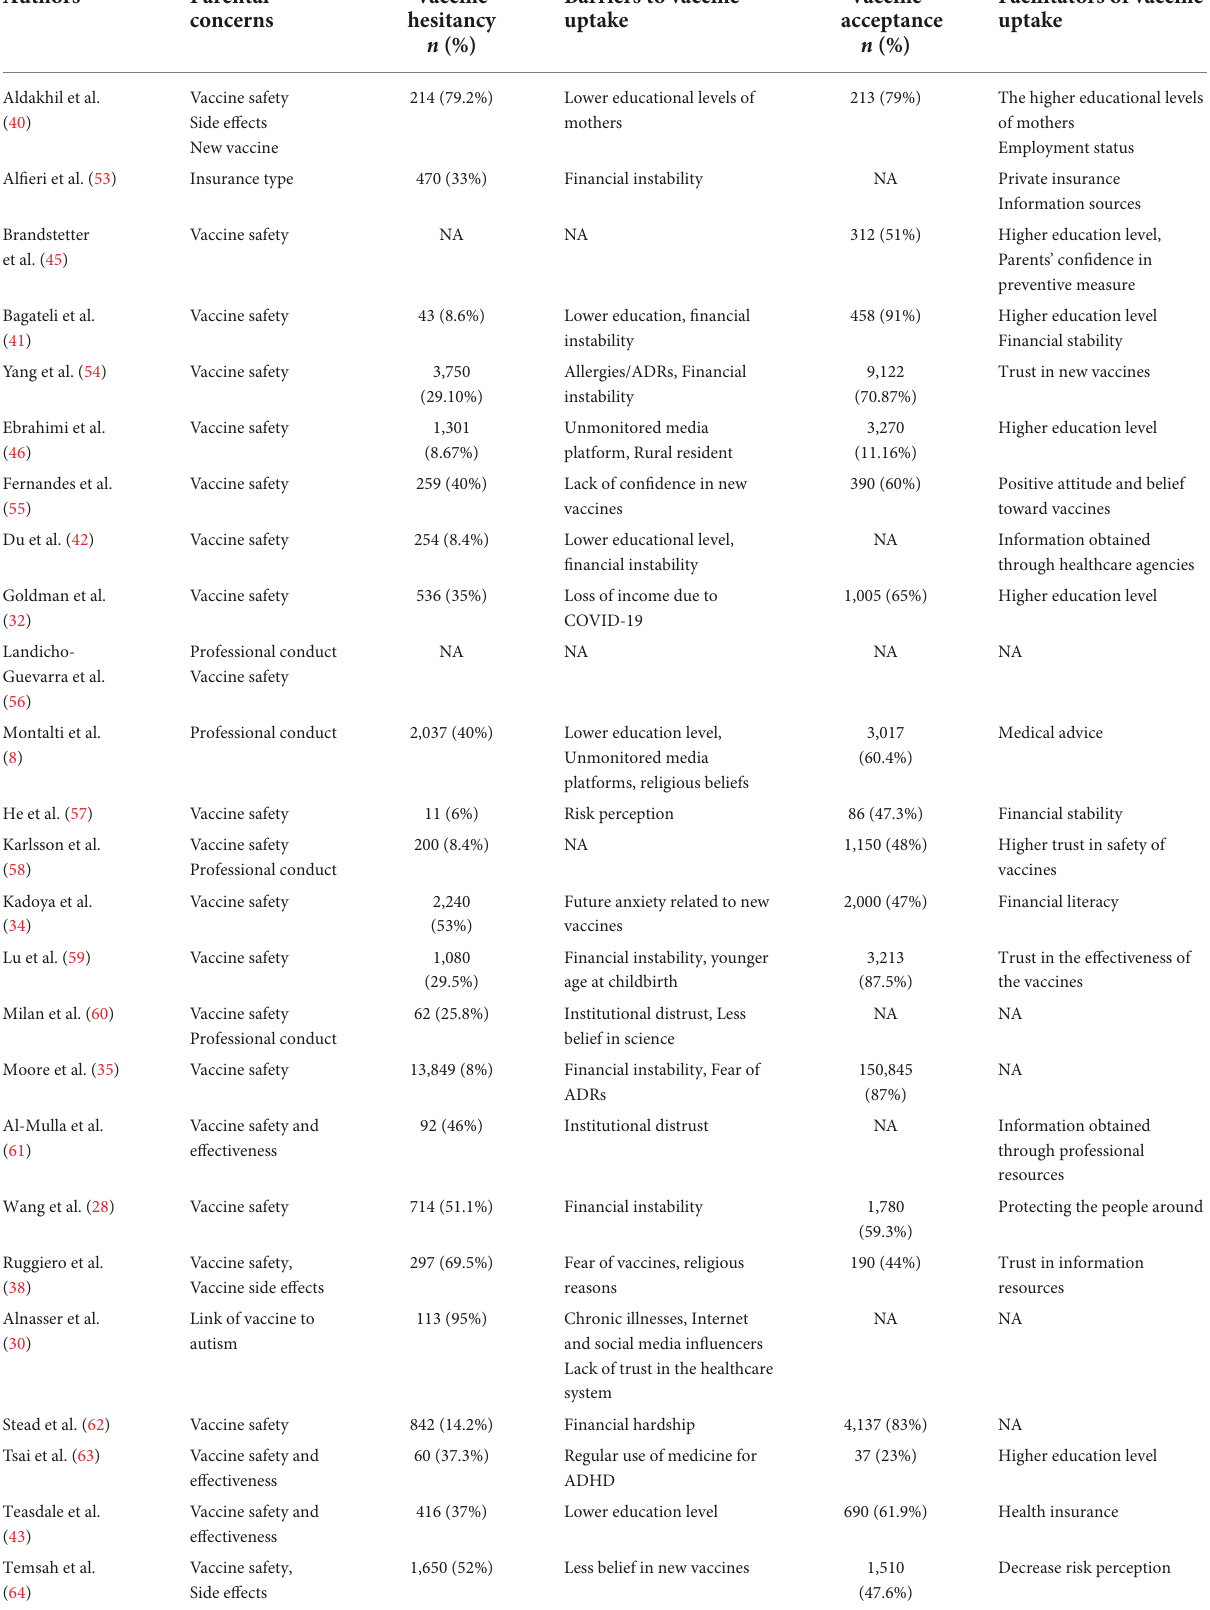
TABLE 3 COVID-19 vaccine hesitancy in children, parental concerns, vaccine acceptance, facilitators, and